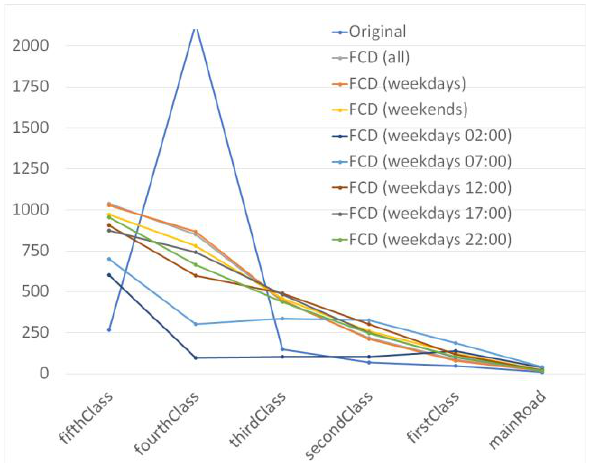
Figure 7 - Number of network features falling in the 6 INSPIRE functional classes in the OTM original dataset and as results of the FCD speed based classification.